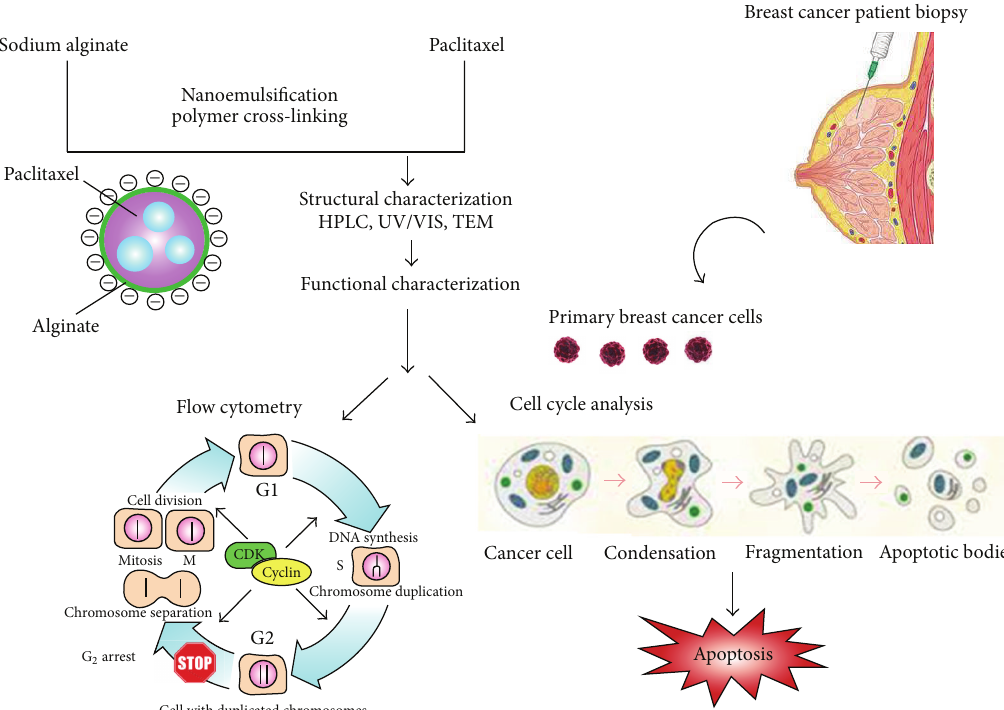
Figure 1: This figure illustrates the design, synthesis, isolation, and functional characterization of paclitaxel-loaded alginate